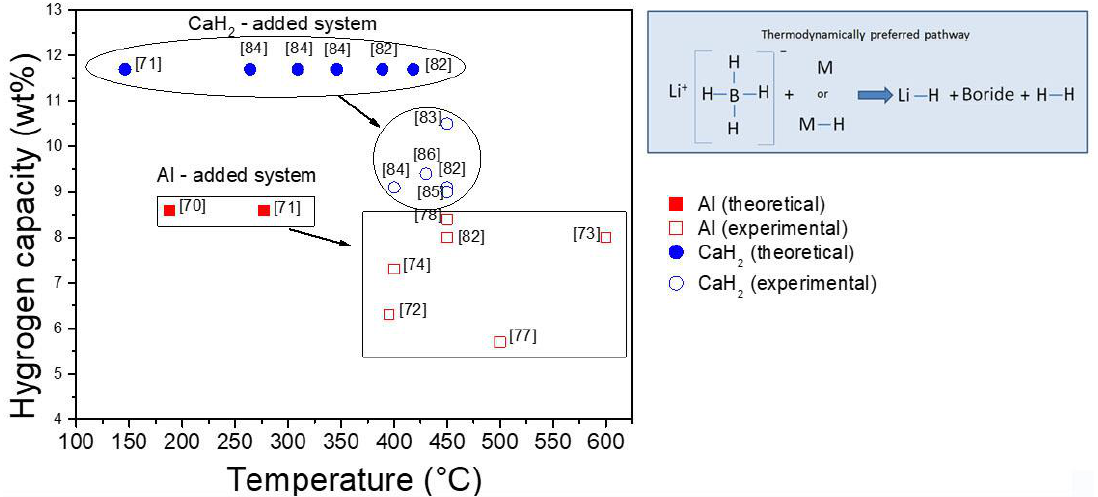
Figure 7. Theoretical and experimental values of hydrogen capacities (wt.%) against the temperature for hydrogen release ( ◦ C) for the LiBH 4 -Al and LiBH 4 -CaH 2 hydride